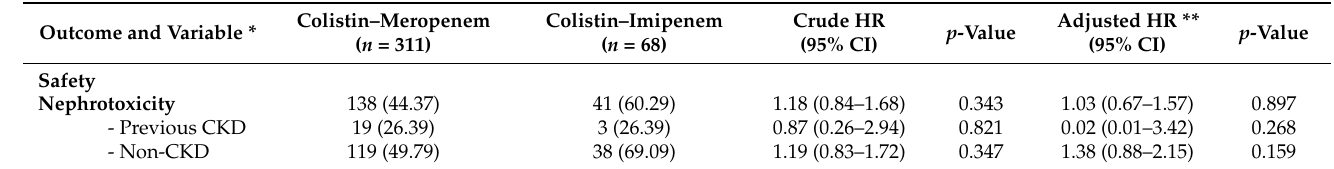
CKD, chronic kidney disease; CI, confidence interval; ** Inverse probability weighting (IPW) using the propensity score for baseline covariate adjustment; HR, hazard ratio; * LD colistin–meropenem